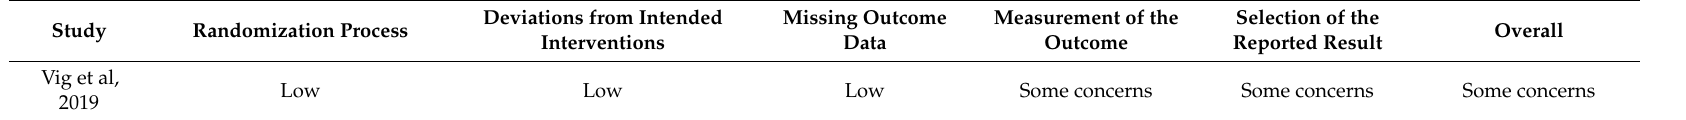
Table 3. Risk of bias of included randomized clinical trials with the RoB 2.0 tool ( n =